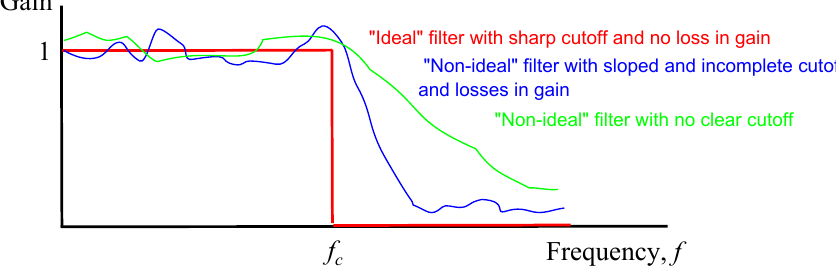
Figure 2. Ideal (red) and non-ideal (blue) filters, showing gains as a function of